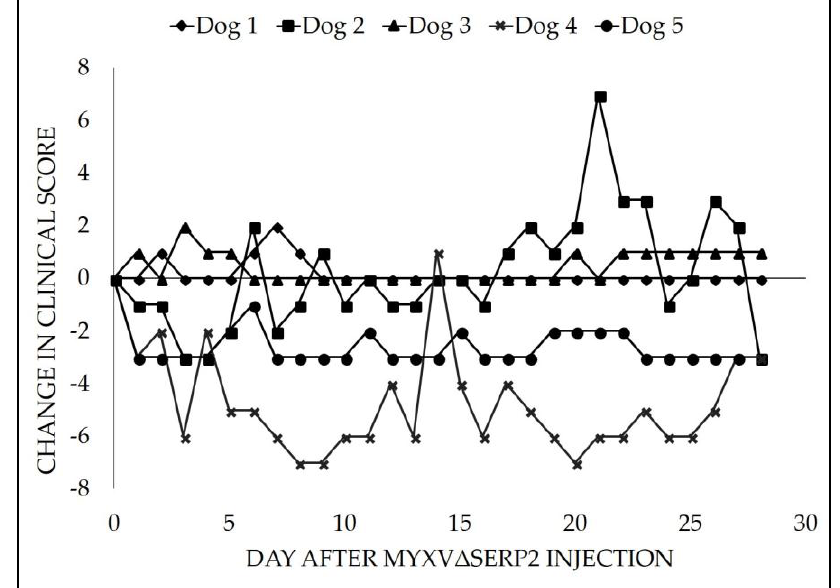
Figure 1. Change in clinical score after an intratumoral injection of 10 6 pfu MYXVΔserp2 in dogs with spontaneously arising soft tissue sarcomas.